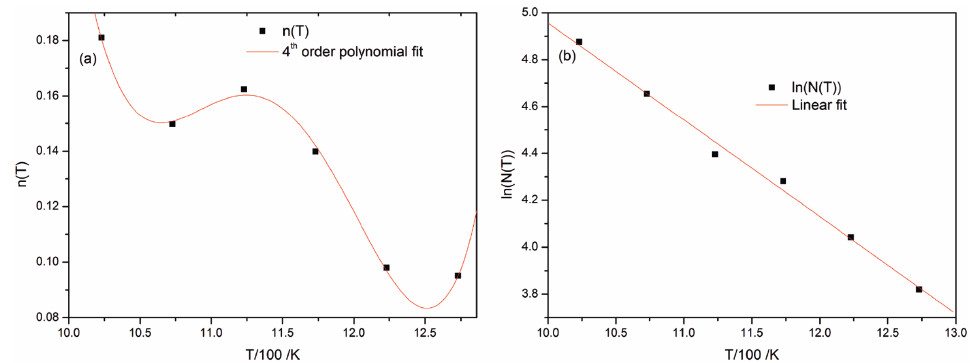
Figure 10: Relationship between (a) n ð T Þ and T = 100; (b) ln ð N ð T ÞÞ and T = 100.